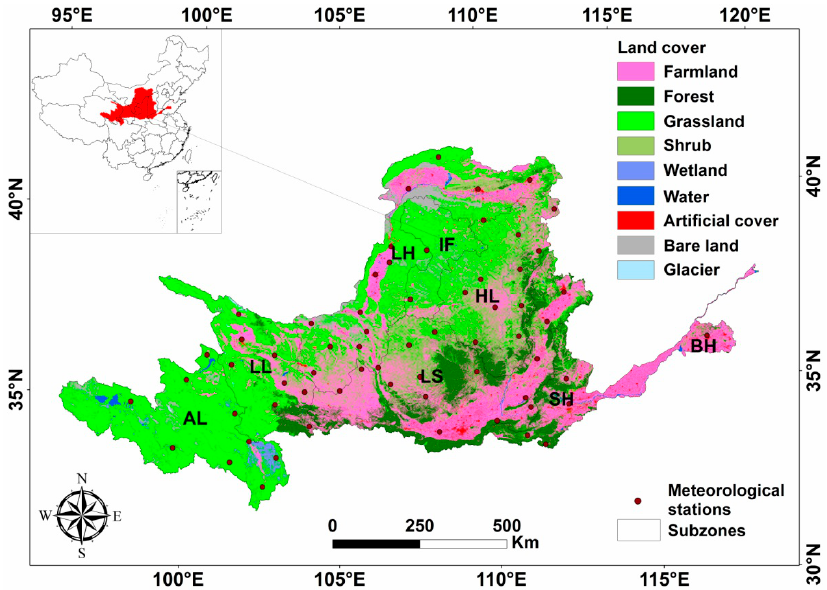
Figure 1. Location map of the Yellow River basin (YRB) with meteorological stations and land cover.